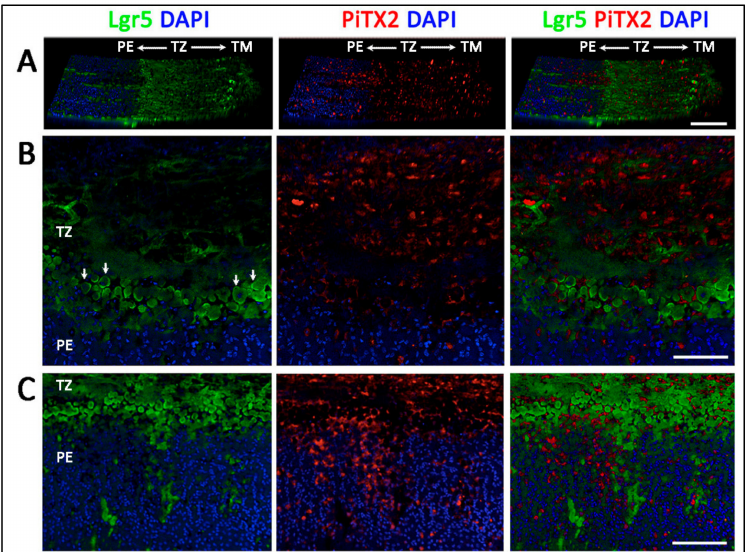
Figure5. ImmunolocalizationofLgr5andPitx2ininnertransitionzone(TZ)andperipheralendothelium (PE) regions. ( A ) A horizontal view tilted at 30 ◦ showed Lgr5 predominantly localized in inner TZ while Pitx2 staining had a pan-TZ pattern. ( B ) Lgr5 and Pitx2 expression in inner TZ region, next to PE. ( C ) Lgr5 positive cell clusters extended from inner TZ into PE. Scale bars: 100 µ